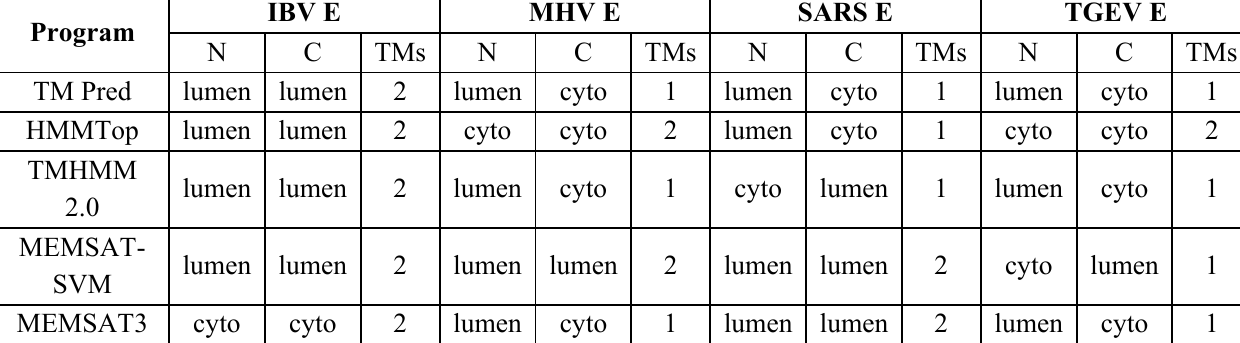
Table 1. TM Pred [93], HMMTop [94], TMHMM 2.0 [95], MEMSAT3 [96],